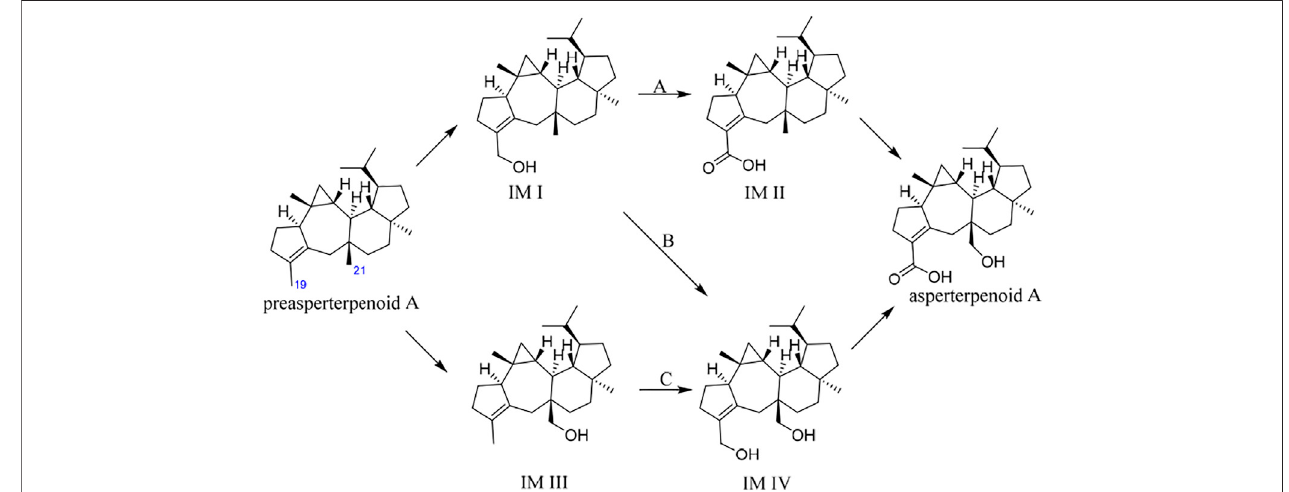
FIGURE 2 | Three possible routes for AstB enzyme catalyzing oxidations.